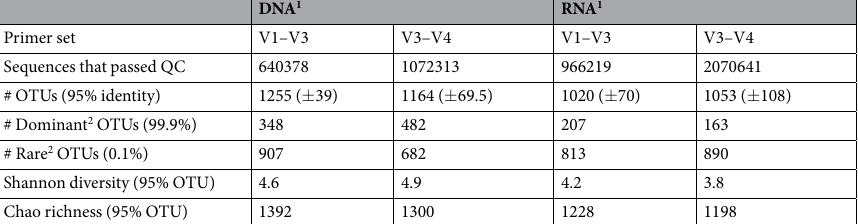
Comparison of the 16S gene regions and the active bacterial community. The taxonomic assignment of the V1-V3 and the V3-V4 16S rRNA sequences derived from the DNA template revealed Cyanobacteria (57% and 56%, respectively) and Proteobacteria (37% and 19%, respectively) as the dominant groups, while Bacteroidetes (3% and 15%, respectively) and Chloroflexi (1.4% and 5.5%, respectively) were among the less abundant phyla (Fig. 2). Particularly, some rare phyla were absent from the V1-V3 dataset (candidate division OD1, Chlamydiae and candidate division NPL-UPA2) relative to the V3-V4 dataset. In particular, this was the case in the RNA frac- tion that also lacked candidate divisions BD1-5, TM6, Hyd24-12 and the Fusobacteria in the V1-V3 dataset. At the genus level, the V1-V3 datasets of the DNA fraction revealed a lower diversity than the V3-V4 dataset, in agreement with the OTU diversity in Table 1. Sequences derived from the RNA template revealed a near absolute dominance of Cyanobacteria that made up 94% and 90% of the V1-V3 and the V3-V4 dataset, respectively, and Proteobacteria constituted 5%. Bacteroidetes and Chloroflexi were found at significant numbers in the V3-V4 dataset (3 and 1% respectively) but constituted less than 0.5% of the V1-V3 dataset. For the RNA fraction no significant difference was observed in Shannon diversity deduced from the genera distribution (data not shown). A Venn diagram was created revealing the number of unique and shared genera between the different nucleotide extraction methods and the analyzed 16S rRNA gene regions (Fig. 3). Out of the 384 identified genera, 69% (264) were shared by all sampling strategies, whereas only a few genera were unique to one of the sampling strategies. Unique to the V1-V3 dataset were 18 genera that were not found in the V3-V4 dataset. These genera included the Cyanobacteria genera, Nostoc and Calothrix , three Planctomycetes, while the majority were Alphaproteobacteria. Sixteen genera were unique to the V3-V4 dataset, and represented mainly Bacteroidetes and Proteobacteria